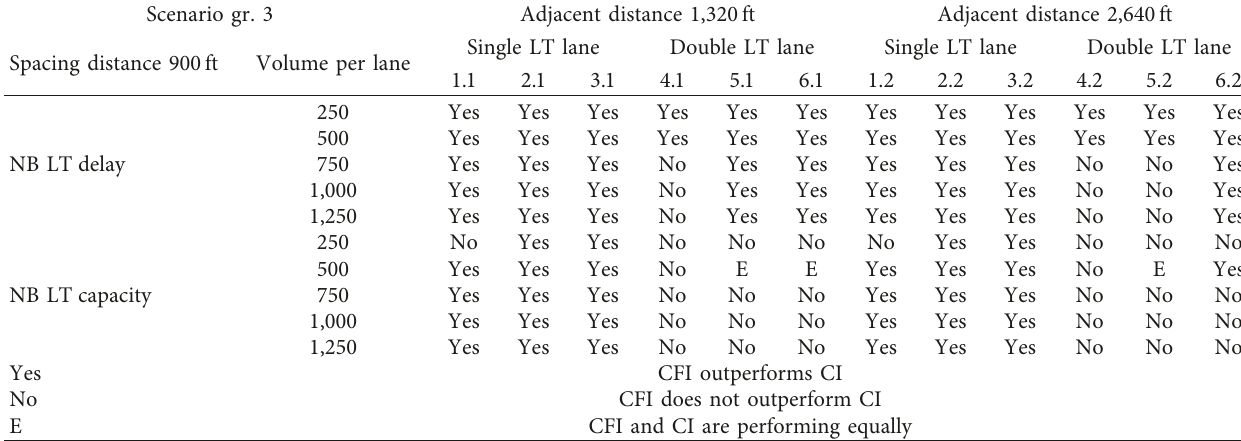
Table 4: Scenario group 3